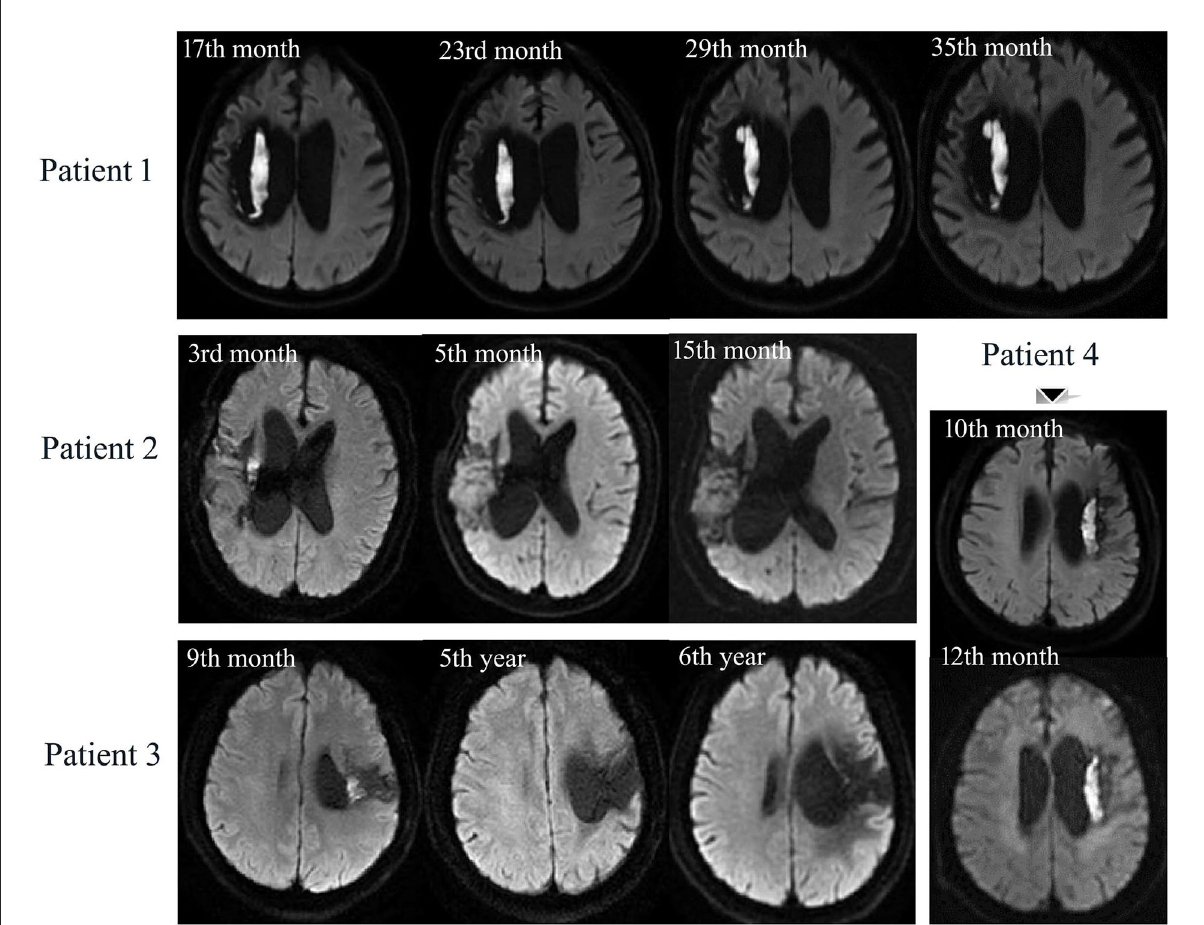
FIGURE3 Longitudinal MRI scans of 4 DWI ( + ) patients with ICH–WS. Patient 1 has persistent DWI lesion during 18 months follow-up. Patient 2: DWI lesion is observable at the 3rd month, shrinks at the 5th month, and disappears at the 15th month. Patient 3: DWI lesion can be seen at the 9th month but disappears at the 5th and 6th year after ICH–WS. Patient 4 has an unchanged DWI lesion during 2 months